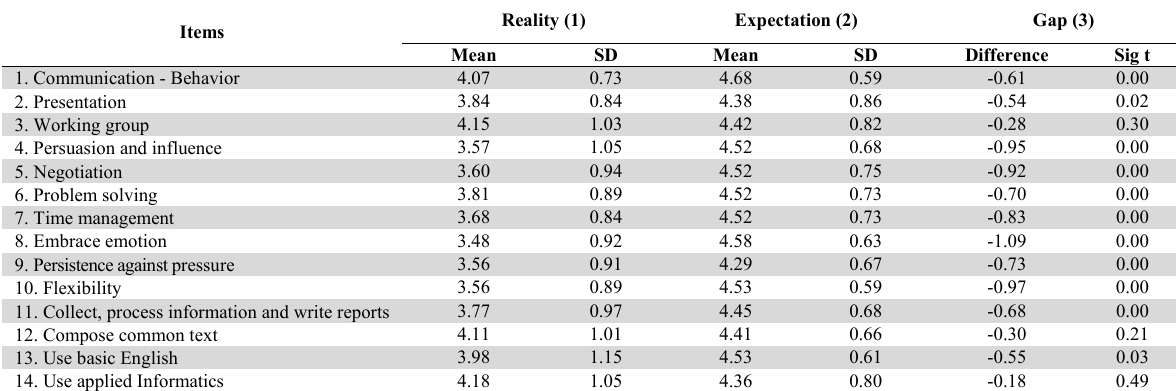
Distance between practical skills and soft skills expectations Reality (1) Expectation (2) Items